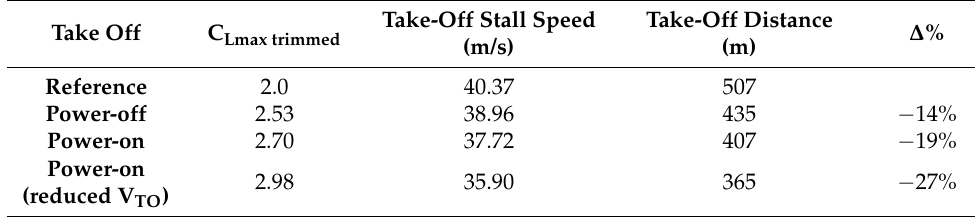
Table 19. DEP effect on the take-off